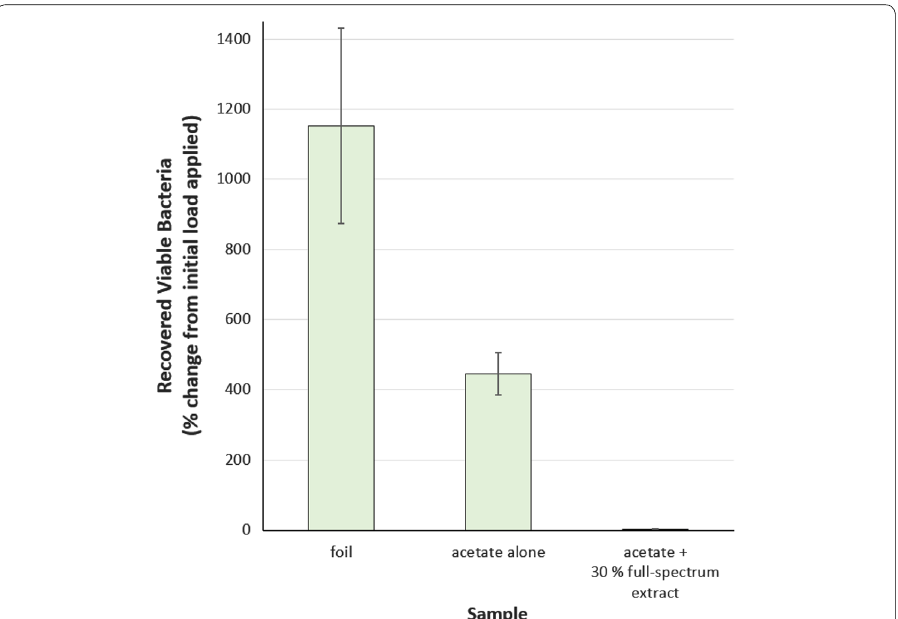
Fig. 4 Foil backing without nanofibers and foil‑backed 100% acetate nanofibers lacked effective antibacterial properties. On three different days (Table 1), samples of plain aluminum foil, aluminum foil‑backed 100% acetate nanofibers, and aluminum foil‑backed acetate nanofibers containing 30% (by weight) full‑spectrum hemp extract were run in parallel. Viable S. aureus were recovered from each sample after a 4 h incubation at 37 °C. The percent increase of viable bacteria, as compared to initial load applied, is displayed. Error bars show standard error of the mean